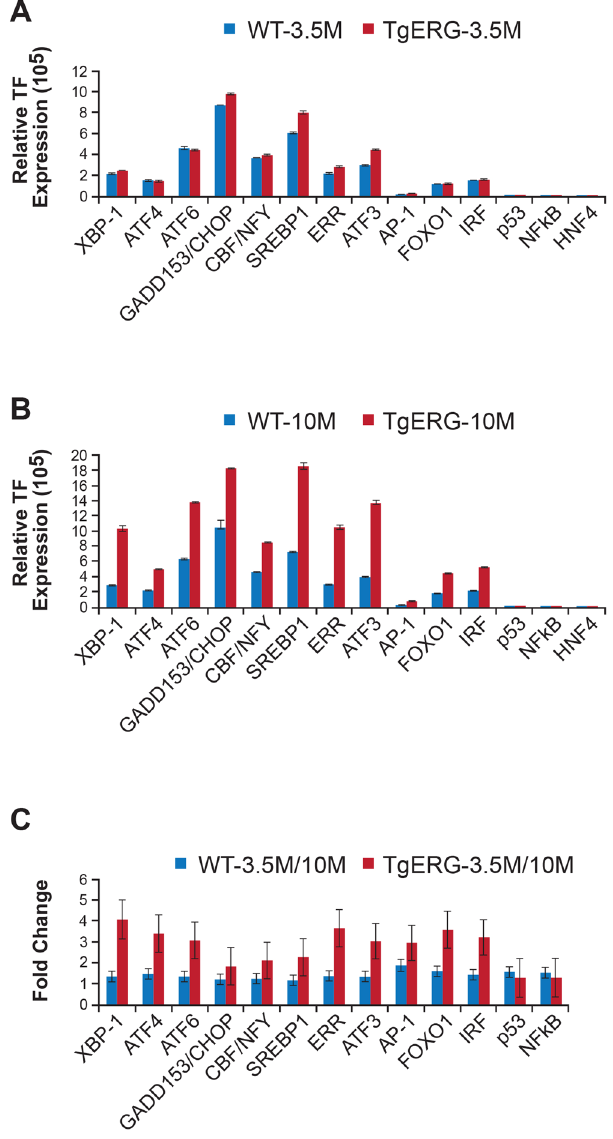
Figure 3. ERG deregulates ER stress transcription factors. ER Stress (UPR) TF Activation Profiling Plate Array was used to analyze transcription factors (TFs) in the prostates of 3.5 and 10 month-old Tg -ERG mice compared to wild-type mice ( A,B ). Activity of ER transcription factors Xbp1, Gadd153/Chop, Cbf/Nfy, Serbp1, Err, Atf3 were slightly up regulated in 3.5 month-old prostates ( A ). However, by 10 months of age, Xbp1, Atf4, Atf6, Gadd153/Chop, Cbf/Nfy, Srebp1, Err, Atf3, Foxo1, Irf were up regulated significantly ( B ). Expression of ER stress transcription factors in 10 month-old prostates from Tg- ERG showed significant increase compared to 3 months old prostates from Tg- ERG ( C